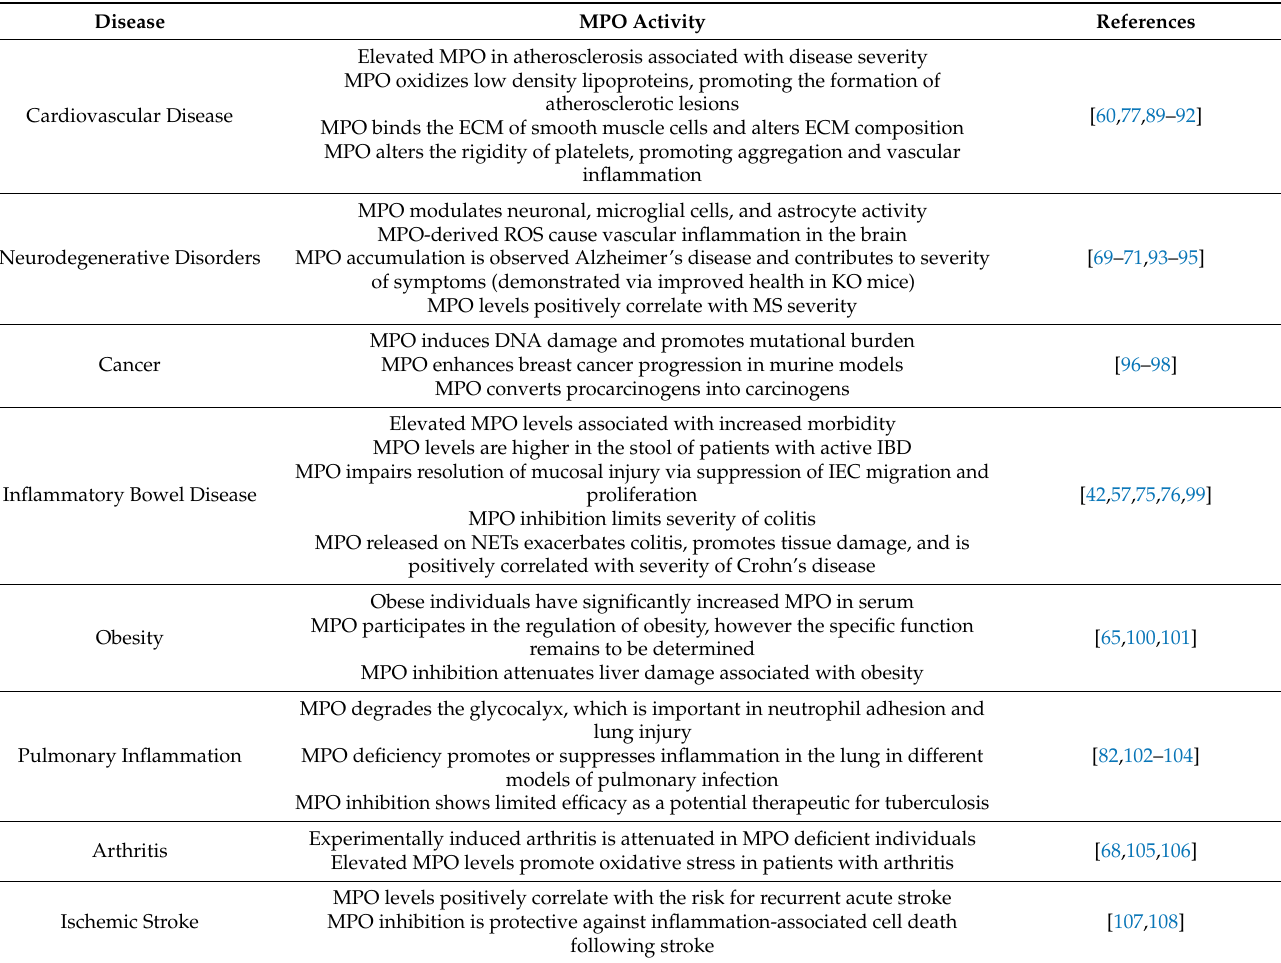
Table 1. Pathological roles of MPO in tissue inflammation and